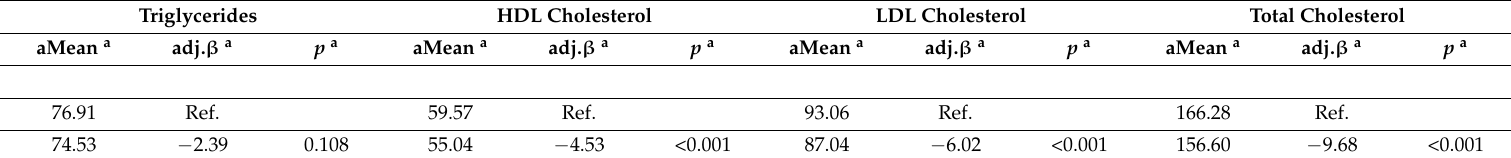
Table 3. The adjusted effects of school-level factors on lipid profile (mg/dL) in